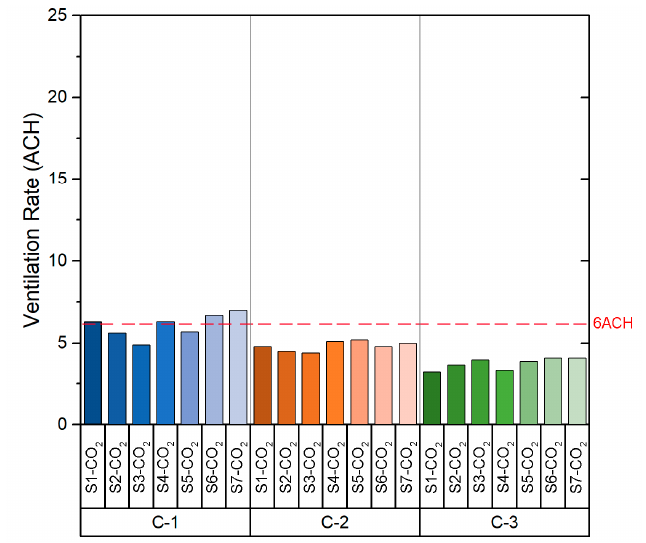
Figure 7. Ventilation rate (ACH) in Classroom B1-A2.